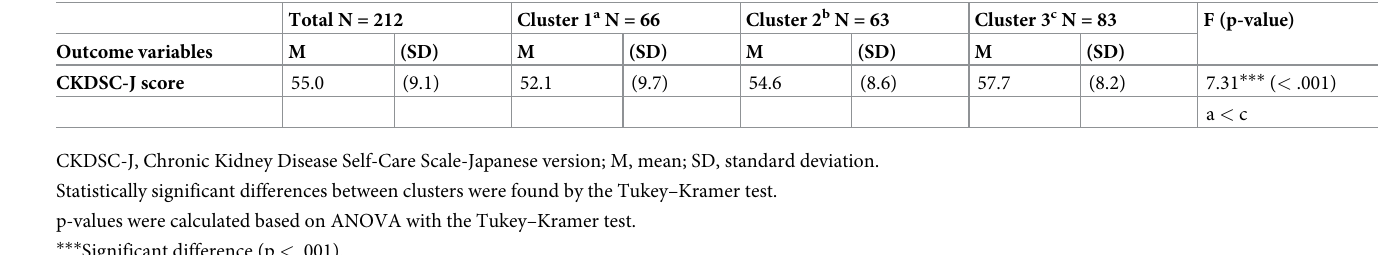
Table 3. Comparison of CKDSC-J score by